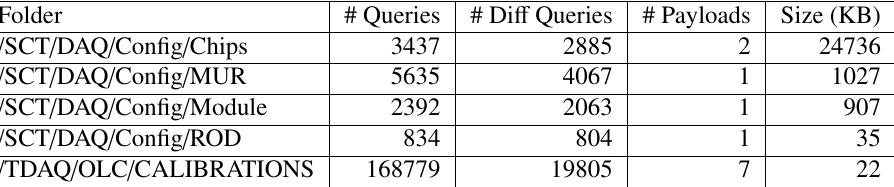
Table 1. Summary table for the caching e ffi ciency results for some folders in the ONL_SCT and ONL_TDAQ schemas. The Payloads column represents the number of unique payloads retrieved by the